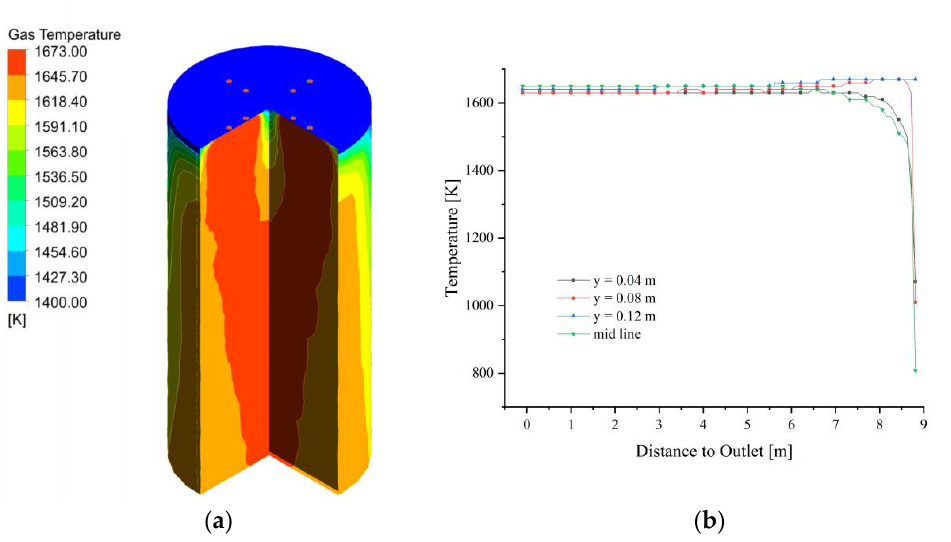
Figure 4. Gas temperature field at 40 mm. ( a ) Gas temperature; ( b ) Gas temperature changes in y = 0.04, 0.08, 0.12 m and mid